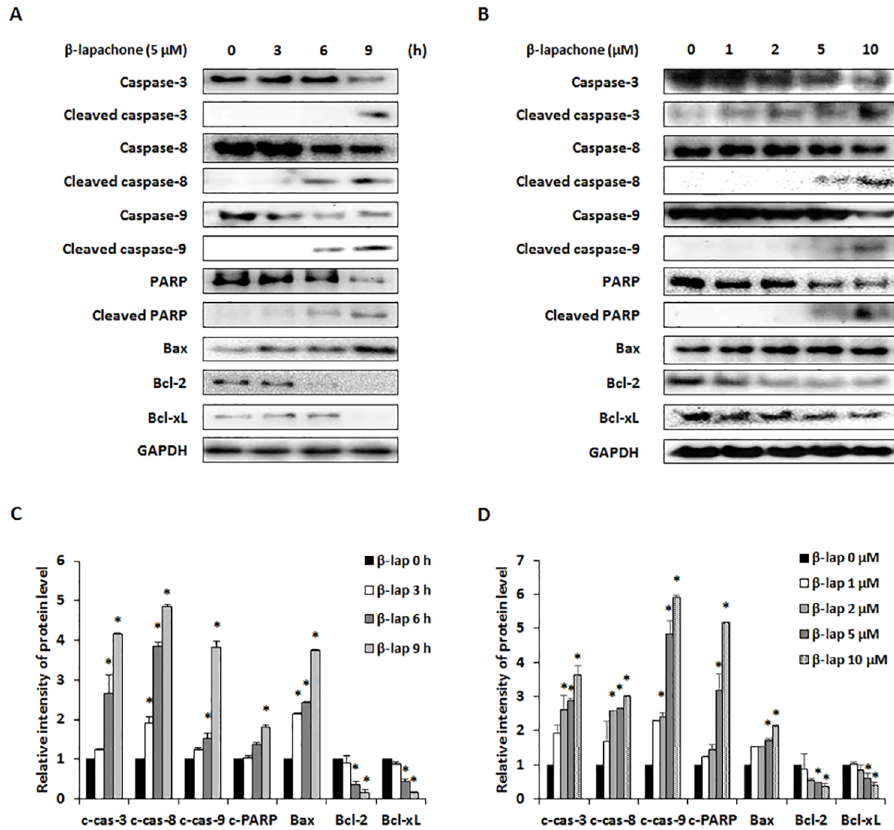
Fig 4. Effect of β -lapachone on the apoptotic pathway in B16F10 cells. A and B. B16F10 cells were treated with β -lapachone (5 μ M) for 0–9 h (A) or variousconcentrations of β -lapachone for 12 h (B). Cell lysates were subjectedto western blot analysiswith PARP, caspase-3, -8, -9, Bcl-2, Bcl-xL, and Bax antibodies. (C and D) Relativelevels of cleavedcaspase-3(c-cas-3), cleavedcaspase-8(c-cas-8), cleaved caspase-9 (c-cas-9), cleavedPARP (c-PARP), Bax, Bcl-2, and Bcl-xL were calculatedusing an Image J program. Values are the means ± SD of data from three independentexperiments. * P < 0.05.